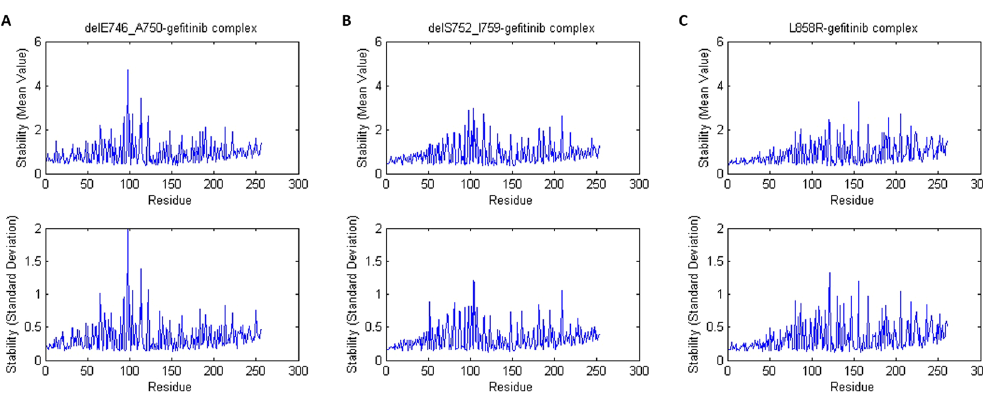
Figure 4. The residue stability of ( A ) delE746_A750-gefitinib complex, ( B ) delS752_I759-gefitinib complex and ( C ) L858R-gefitinib complex. The upper panels showed the mean value and the lower panels showed the standard